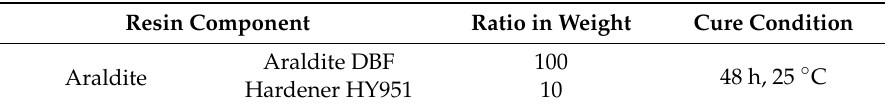
Table 1. Resin ratio and cure condition.